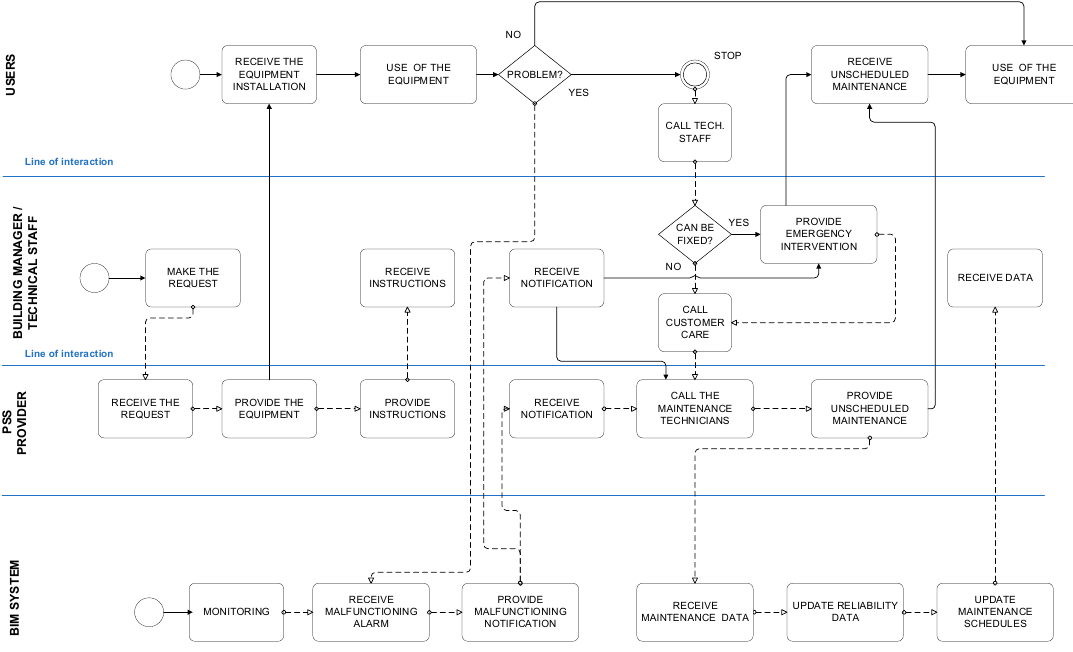
Figure 8. BPMN map of the new extraordinary maintenance processes.